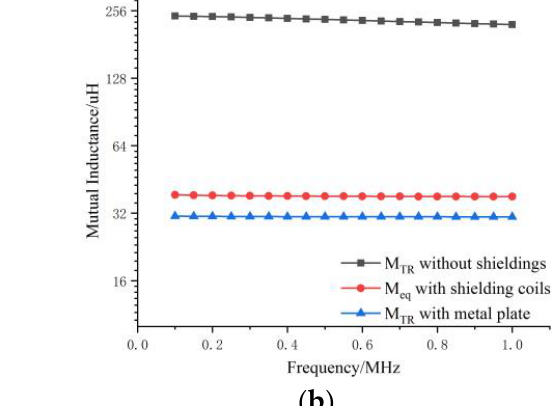
Figure 6. The distribution of electric field: ( a ) the system without shield; ( b ) the system with shielding coils; ( c ) the system with metallic plate as shield.